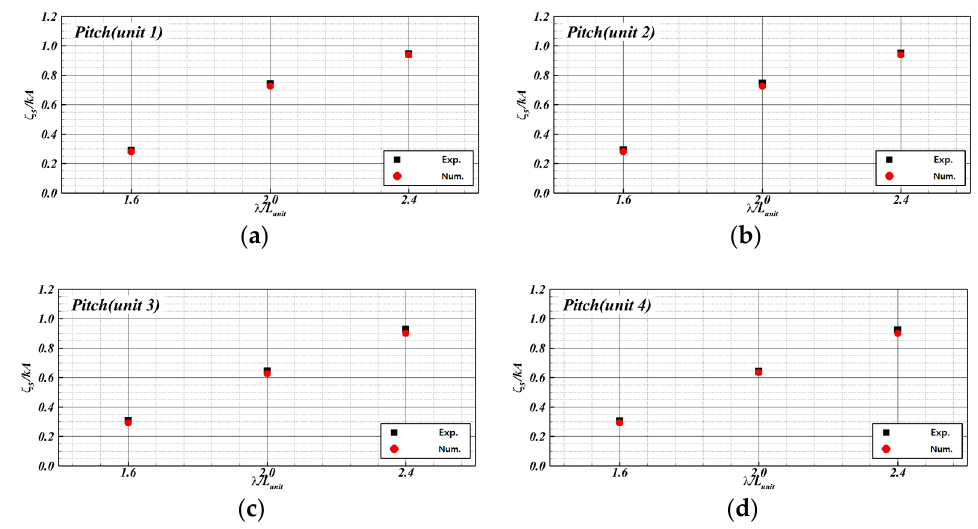
Figure 23. Pitch RAOs for 𝑯/𝝀 = 0.05 under head sea: ( a ) Unit 1; ( b ) Unit 2; ( c ) Unit 3; ( d ) Unit 4. Table 7. Comparison of total tension determined by experiment and computation at 𝑯/𝝀 = 0.05.